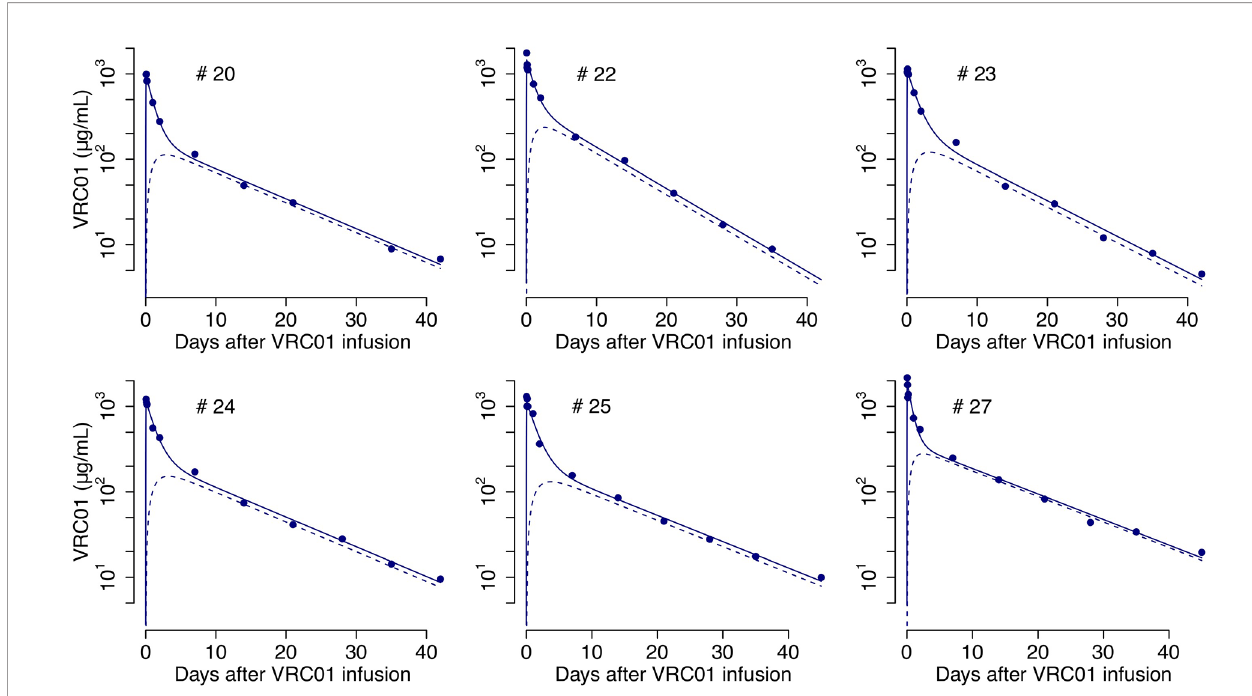
FIGURE 2 | Best- fi ts of the two-compartment model in equations (2)-(6) to the PK data from infected individuals. Blue circles represent the measured VRC01 serum concentration, and solid lines the best fi t from the model in equations (2) and (4) of the VRC01 concentration in the blood. Dashed lines represent the predicted concentration of VRC01 in the second compartment from the model in equations (3) and (6), assuming plasma volume, Vol 1 = 3 L and Vol 2 = k 12 Vol 1 k for each participant ’ s parameter